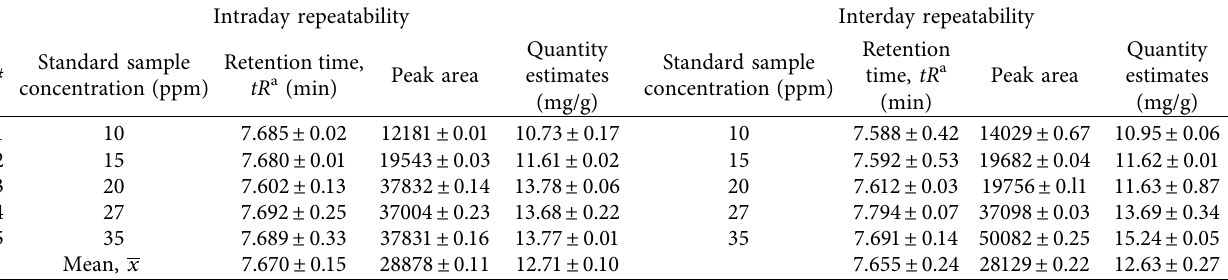
Figure 1: (a) Preparative HPLC calibration curve for betanidin 5- β -D-glucopyranoside standard; (b) passing and Bablok fit of betanidin 5- β -D-glucopyranoside standard in B. vulgaris L. peels and pomaces extracts determined with TSQ-MS. Table 2: Intraday and interday repeatability at various